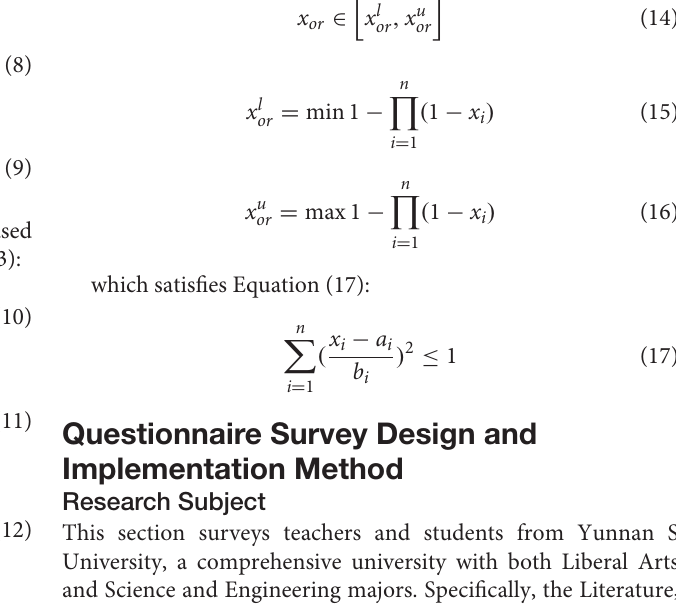
where a i is the nominal value, and b i is the deviation; x i is